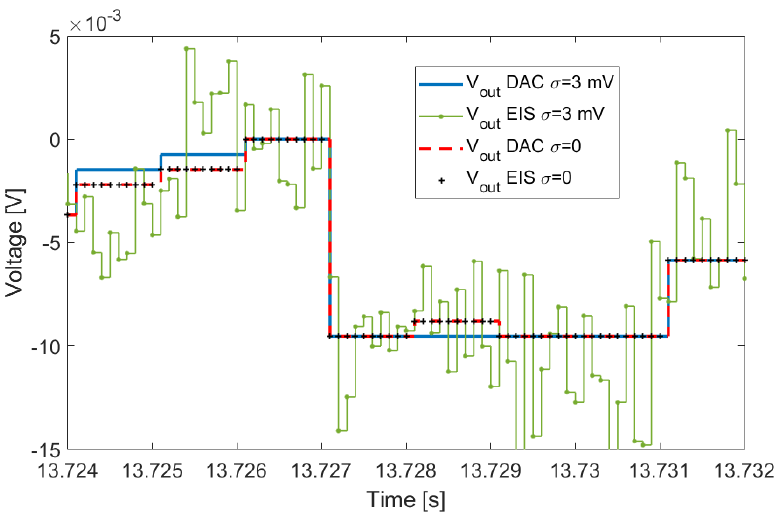
Figure 6. V out resulting from (2) simulated as a zero-order-hold signal generated by the DAC and sampled with the ADC2 of the EIS instrument. See Section 3.4.2 for more